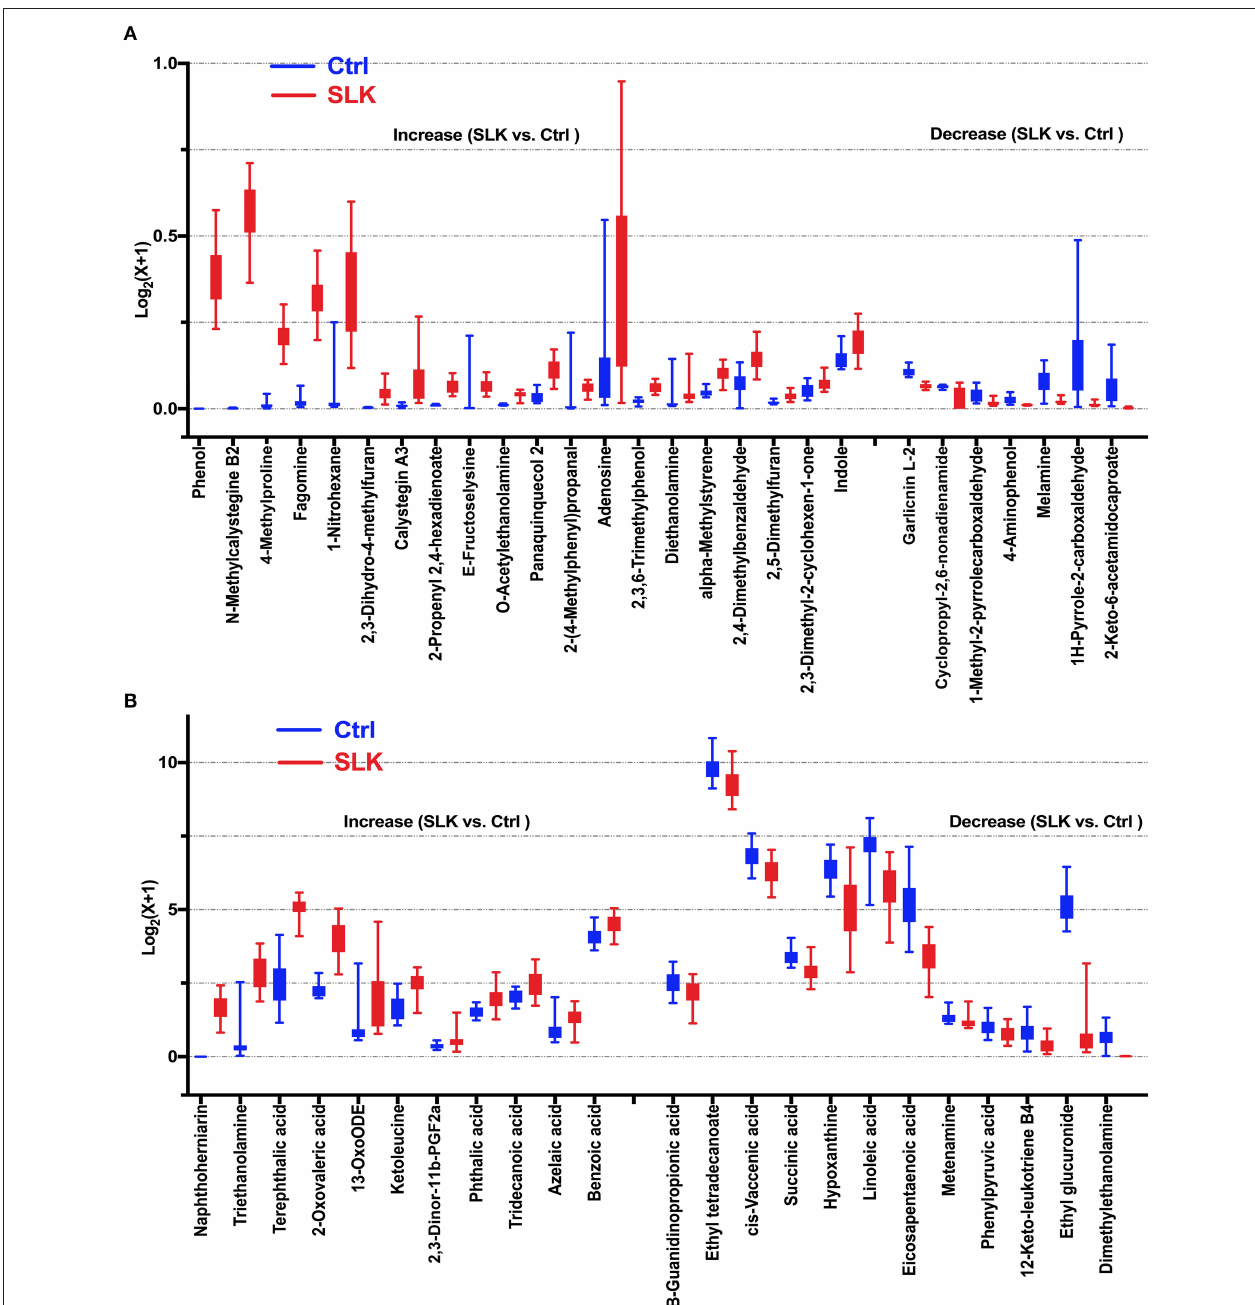
FIGURE 2 | Boxplots show significantly altered metabolites in the tears of SLK patients. Compared with Control subjects, 19 decreased metabolites and 31 increased metabolites represented by relative expression in the boxplot (SLK vs. Ctrl: P < 0.05). Specifically, for better visualization of box plots in this analysis, the expressions of the metabolites was converted into log2(x + 1) values and a different Y-axis scales and range were applied in (A,B) . (A) Metabolites with maximum converted values less than 1 [log2(x + 1) ≤ 1], (B) Metabolites with maximum converted values more than 1 [log2(x + 1) > 1]. Both figures present increased metabolites in the left [20 in (A) , 11 in (B) ] and decreased metabolites in the right [7 in (A) , 12 in (B) ], separated by two tick